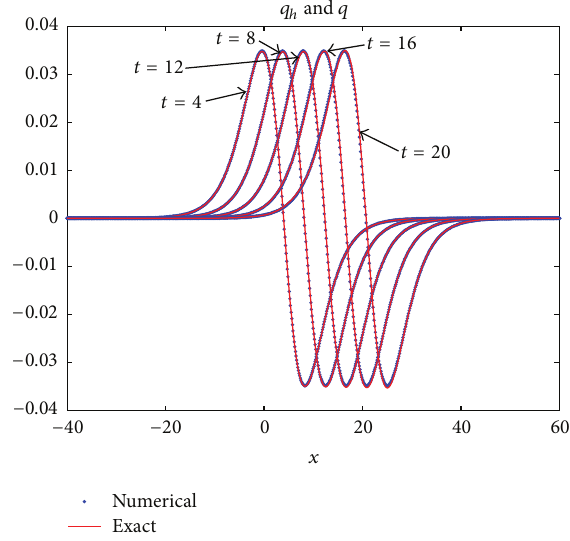
Figure 6: Comparison between 𝑞 and 𝑞 ℎ at times 𝑡 = 48 , 12 , 16 , and 20 with ℎ = 0.125 and Δ𝑡 = 0.2 .